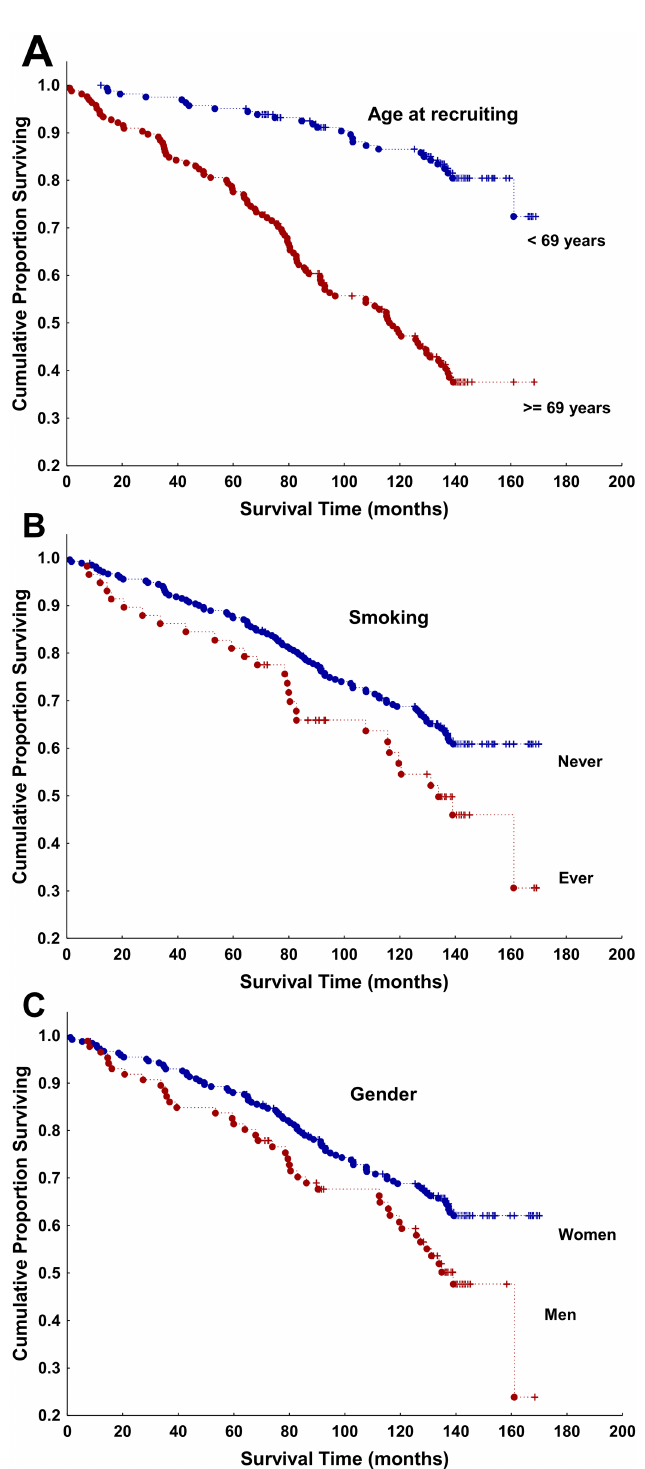
Fig 2. Kaplan-Meier survival curves of all patients with RA stratified by demographic factors. (A) Stratified by age in relationwith the median age at the time of recruitment (red (cid:21) 69 years, blue < 69 years); (B) stratified by smoking habit (red = ever smoker, blue = never smoker), and (C) stratified by gender (red = men, blue = women). Dots = deaths, crosses = censoreddata.